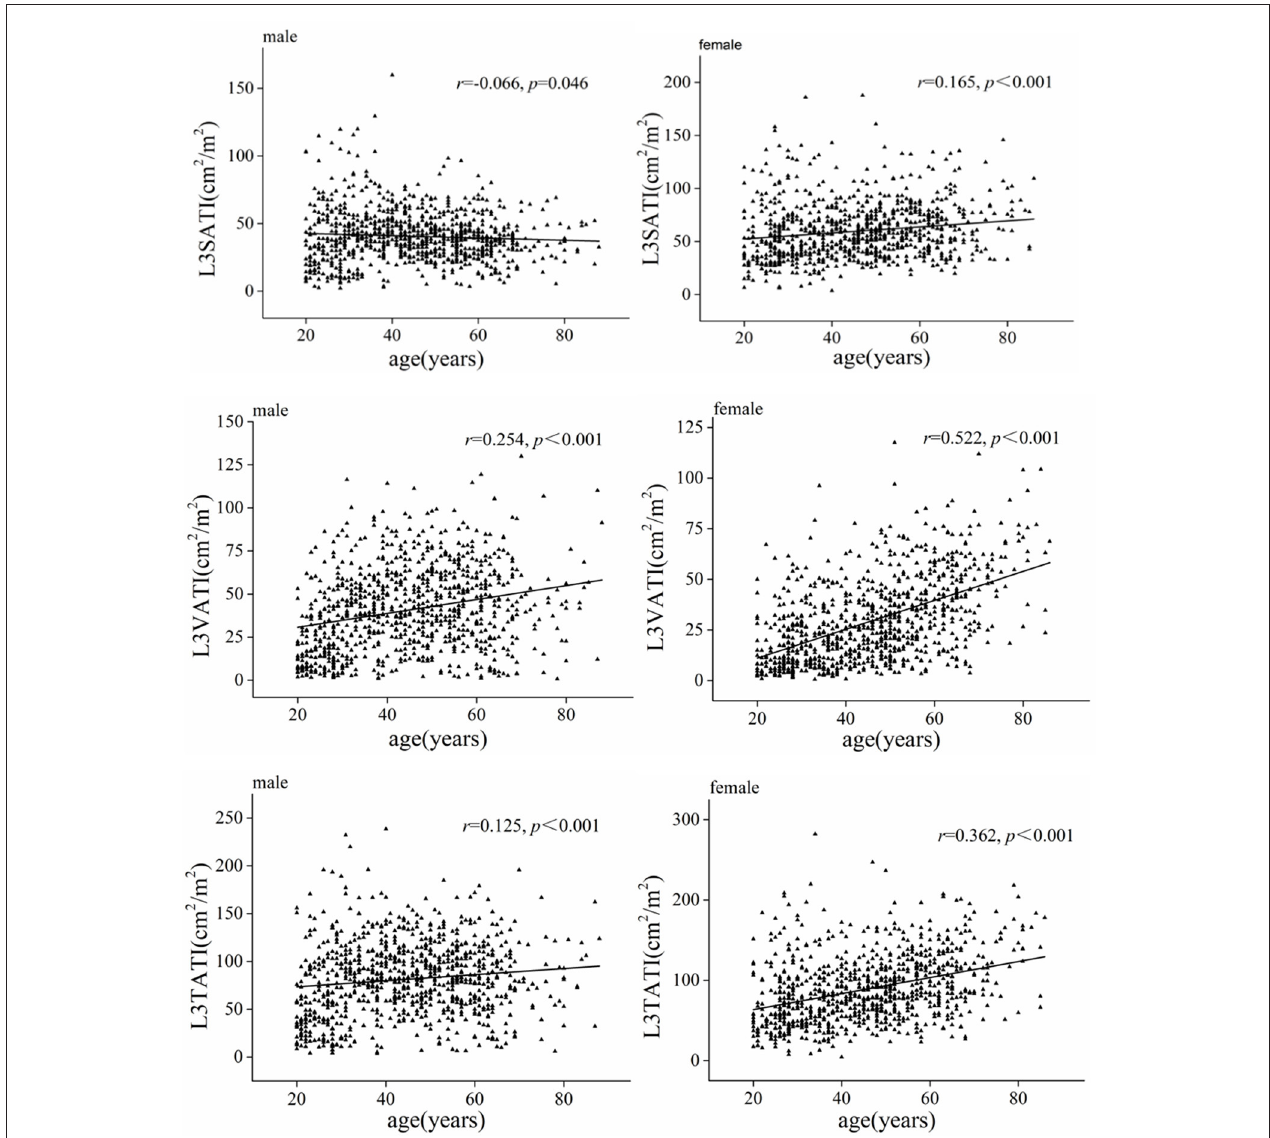
FIGURE 2 | Scatter graph depicting correlations between adipose tissue index (VATI, SATI, and TATI) and age classified according to sex.